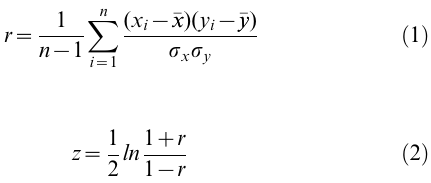
algorithm, 2) Map microarray Probe IDs to systematic MGI